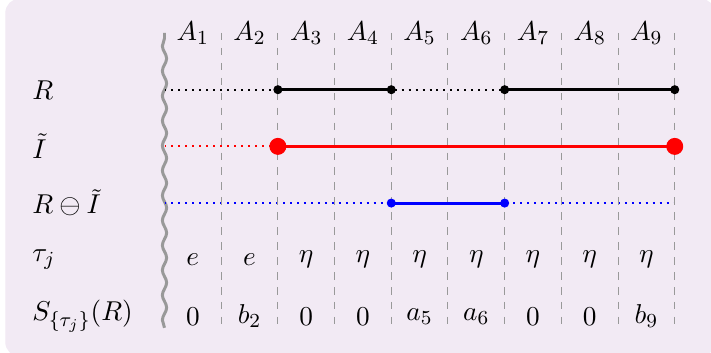
Figure 6 . An example of a contribution to the entropy associated to { τ j } . Using the shorthand a j = log d A ≈ S T ( u j − 1 , u j ) and b j = log d B ≈ S BH ( u j ) , the entropy is S rad j j a 6 + b 9 = S BH ( u 2 ) + S T ( u 4 , u 6 ) + S BH ( u 9 ) and the figure shows the relation to the islands-in-the- rad stream